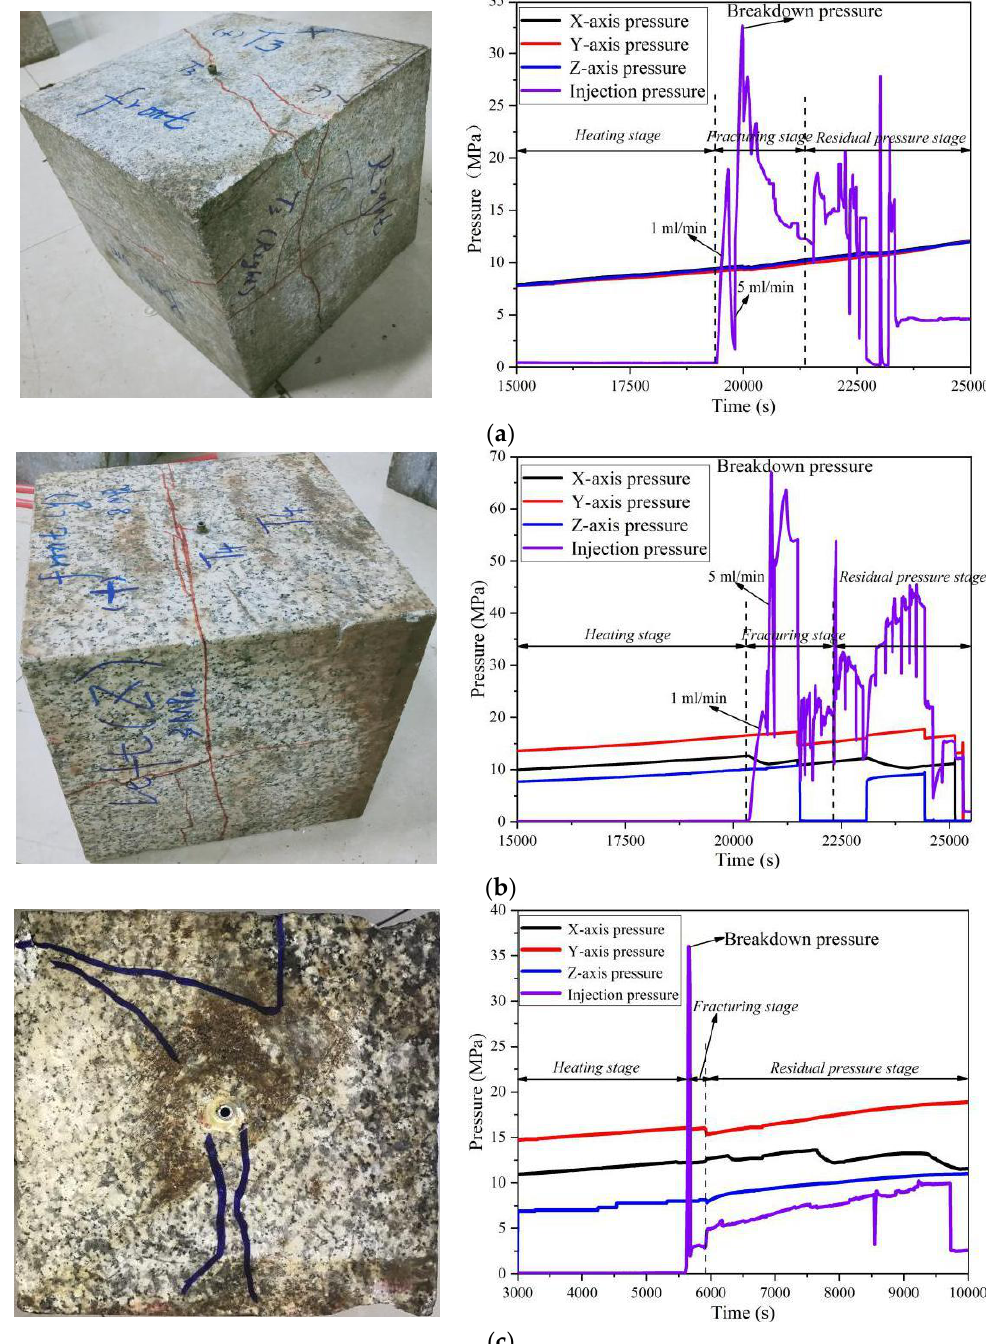
Figure 9. Fractured monzogranite samples under high temperature of 150 °C and pressure-time curves for different injection rates. ( a ) MG-7 sample (5 mL/min), ( b ) MG-8 sample (5 mL/min), ( c ) MG-9 sample (25 mL/min).